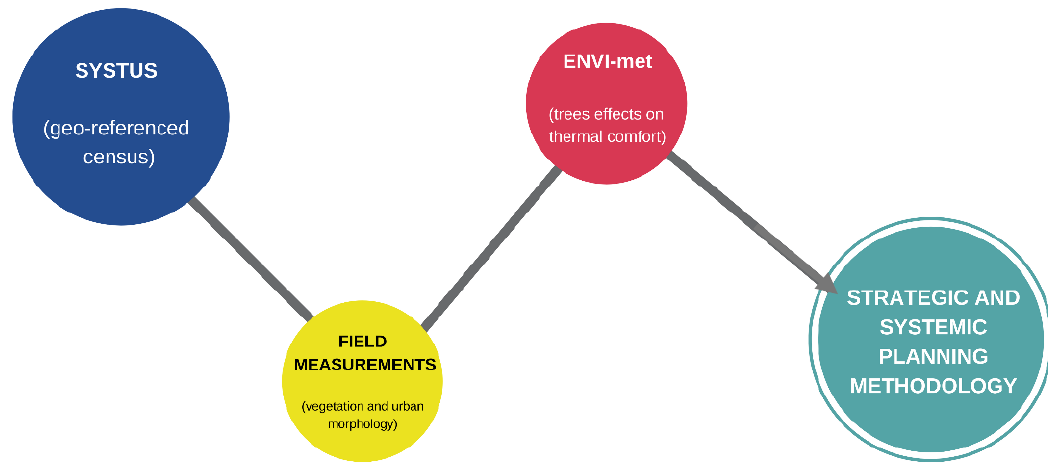
Figure 2. Methodological steps.